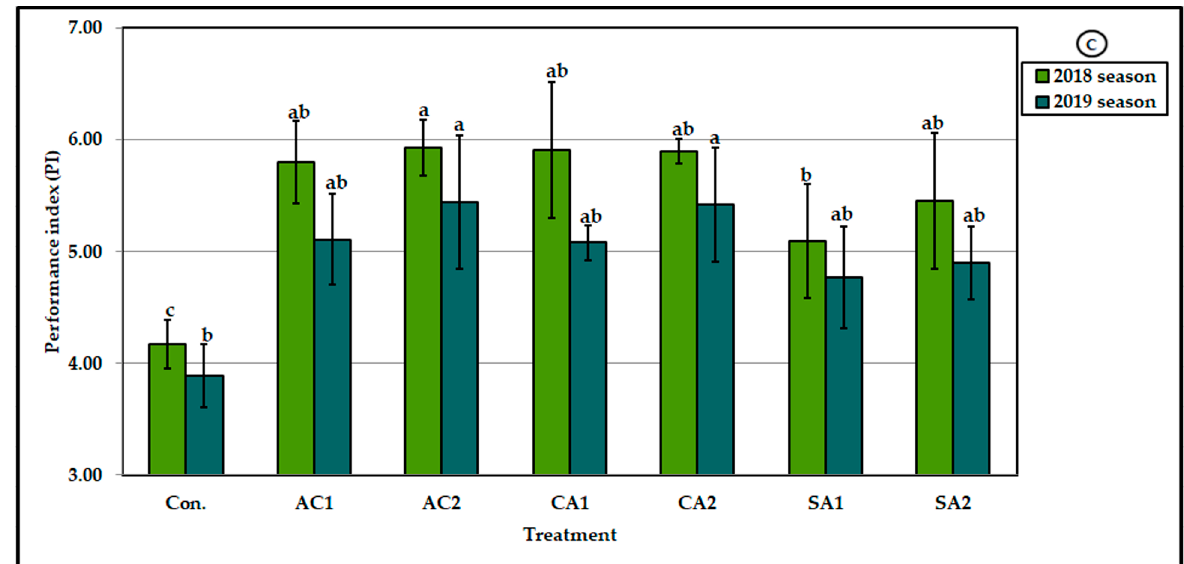
Figure 3. Impact of soil pH induced by some acidifying agents applied to ( A ) SPAD reading, ( B ) fv/fm, and ( C ) performance index (PI) of olive trees picual cv. grown in a sandy loam clay soil under multi-abiotic stresses (pH = 7.78 vs. 7.89; CaCO 3 = 8.8 vs. 9.2%; and ECe = 6.4 vs. 7.2 dS m − 1 ). Different letters in each column indicate significance at p ≤ 0.05. CA 1 , CA 2 , AC 1 , AC 2 , SA 1 , and SA 2 represent citric acid, acetic acid, and sulfuric acid applied at 25 and 50 cm 3 , respectively.